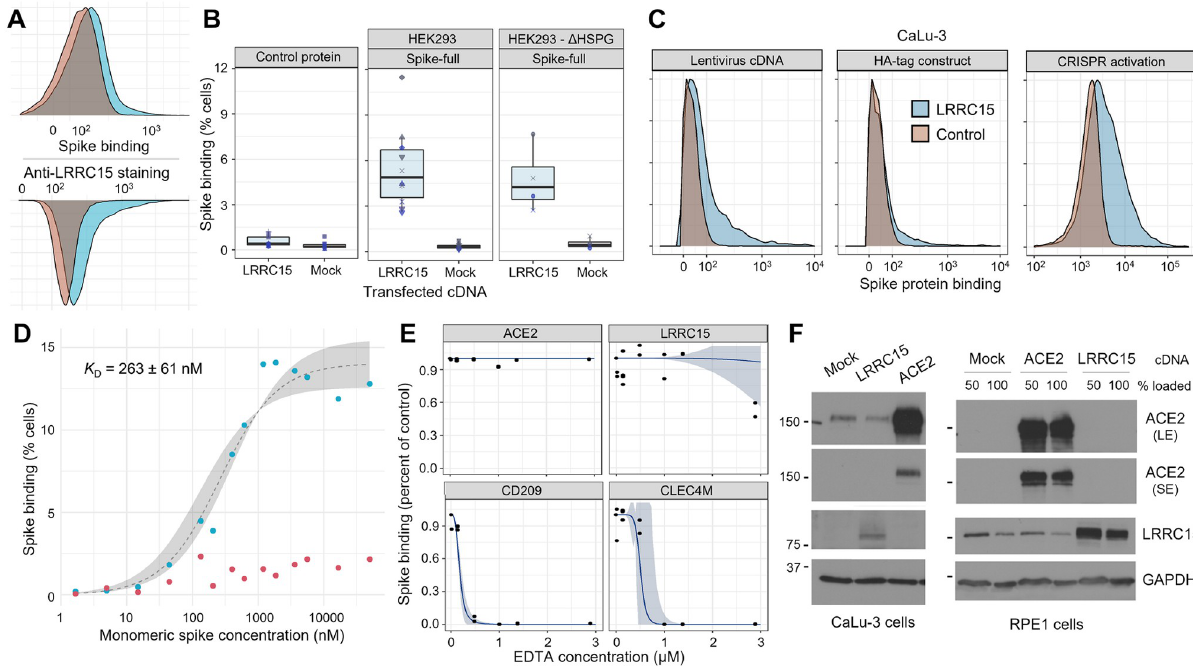
Fig 2. The spike:LRRC15 interaction is robust to cellular context and differs from previously described spike-binding receptors. ( A ) Comparison of the cell surface staining profiles of HEK293 cells transfected with LRRC15 cDNA with spike protein (top) and anti-LRRC15 antibody (bottom). ( B ) LRRC15 binding to spike is specific and independent of heparan sulfate proteoglycans. Boxplots summarizing spike binding of LRRC15-transfected cells compared to mock-transfected cells in wild-type HEK293 cells (center panel), a HEK293 strain deficient in cell surface heparan sulfation following SLC35B2 knockout (right panel) and HEK293 cells binding a control tetramer instead of spike (left panel). ( C ) LRRC15 expression consistently induces spike binding. LRRC15 overexpression was achieved in a CaLu-3 human lung cell line using three different approaches and increases in spike binding as quantified by flow cytometry. ( D ) Binding of SARS-CoV-2 spike protein to LRRC15-expressing cells is saturable. Spike binding to LRRC15-expressing (blue) and control (red) cells was quantified by flow cytometry over a wide range of fluorescently conjugated monomeric spike concentrations. A sigmoidal regression curve was fit (gray) to estimate the equilibrium dissociation constant. ( E ) EDTA blocks known lectin receptors for spike protein but does not prevent LRRC15 binding. Dose–response curves (blue) are fit to flow cytometry measurements of spike binding to HEK293 cells under different concentrations of EDTA. ( F ) Expression of LRRC15 is not linked to ACE2 protein production. Western blots with antibodies against human ACE2 and LRRC15 detect no up-regulation of ACE2 when LRRC15 is overexpressed or vice versa in either an ACE2-negative cell line (RPE1) or ACE2-positive cell line (CaLu-3). ACE2 is shown as both short (SE) and long (LE) exposures. Molecular masses are indicated in units of kilodaltons. ACE2, angiotensin-converting enzyme 2; LRRC15, leucine-rich repeat containing protein 15; SARS-CoV-2, Severe Acute Respiratory Syndrome Coronavirus 2.